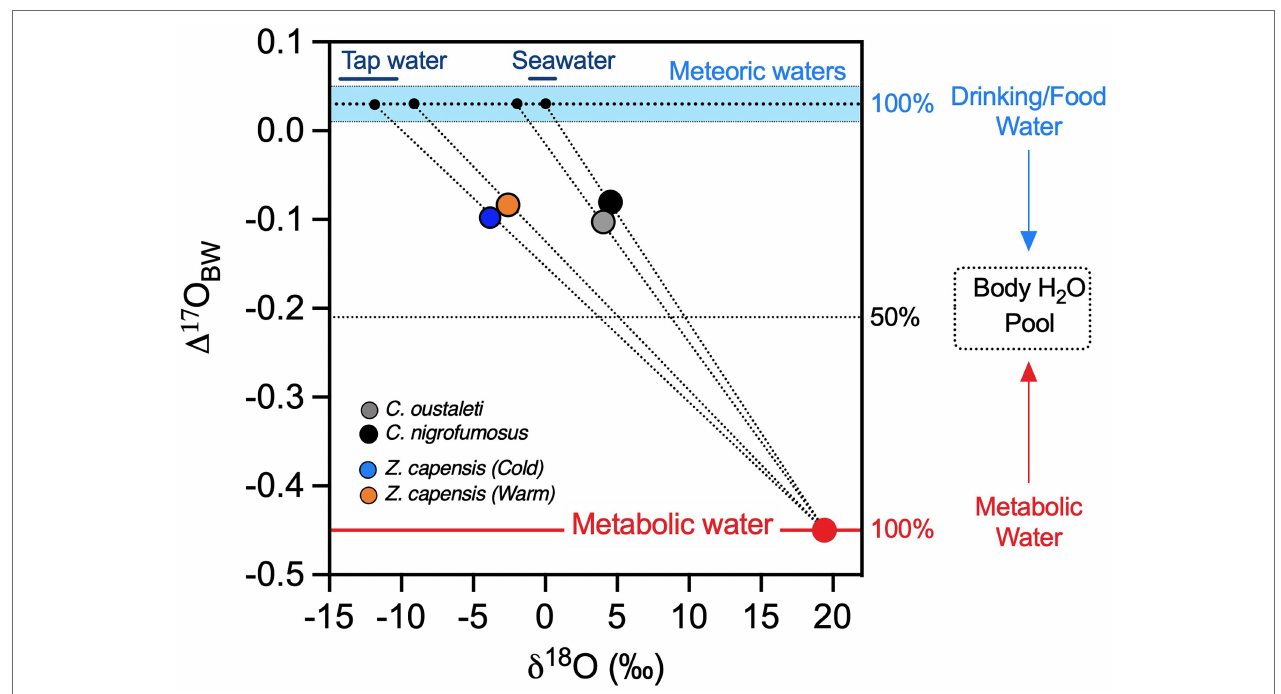
FIGURE 4 | Measured mean Δ' 17 O values (y-axis) and δ 18 O values (x-axis) of body water used to estimate the δ 18 O value of ingested drinking/food water of captive Z. capensis and wild Cinclodes . Captive Z. capensis was predicted to have ingested drinking/food water with a δ 18 O value of − 12‰, which is consistent with tap water in Santiago, Chile. Cinclodes were predicted to have ingested drinking/food water with a δ 18 O value of ~0‰, similar to seawater and consistent with their reliance on marine resources. Ranges of δ 18 O values for tap water and seawater are shown by solid bars at the top of the range for meteoric waters (sky-blue dashed area). The dotted lines represent the solutions for equation 2 for each group of